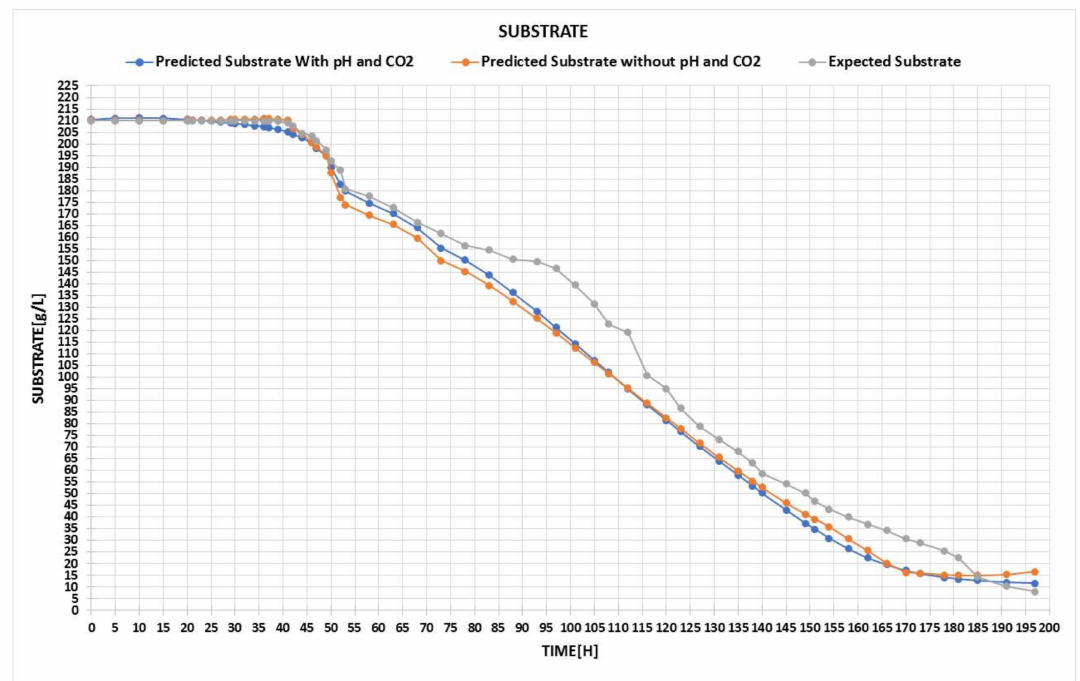
Figure 13. Substrate prediction, based on different types of data